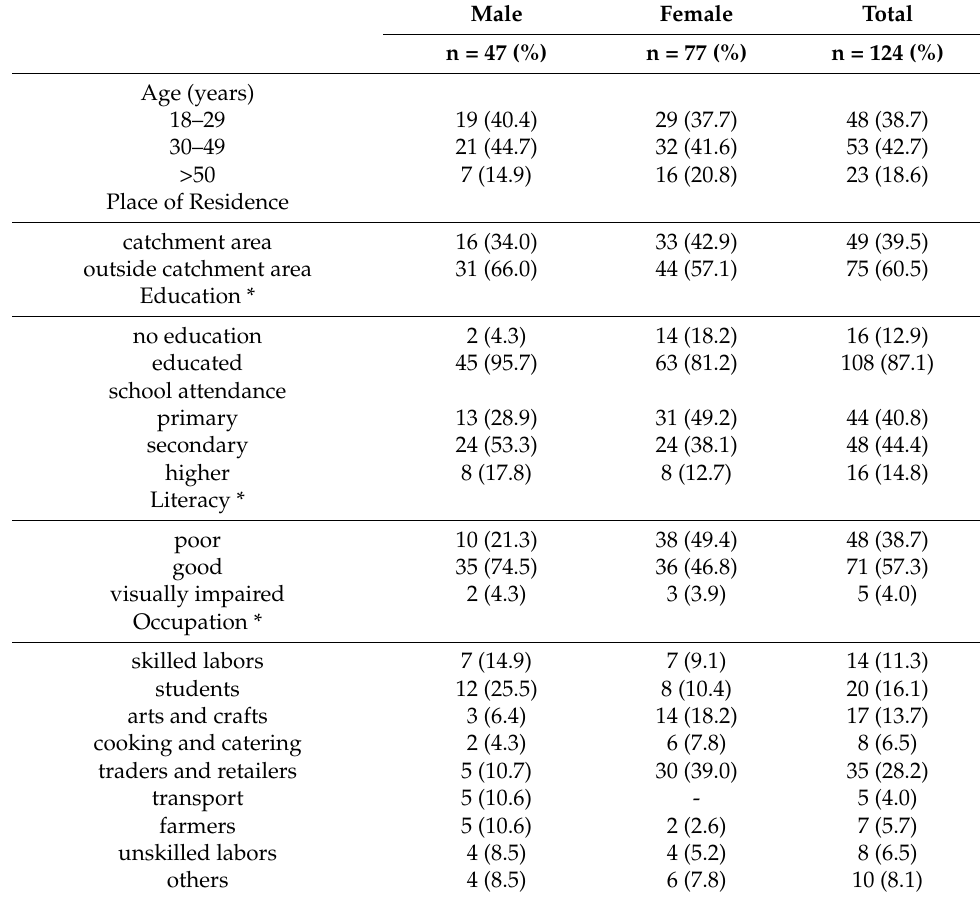
Table 1. Sociodemographic characteristics of malaria patients